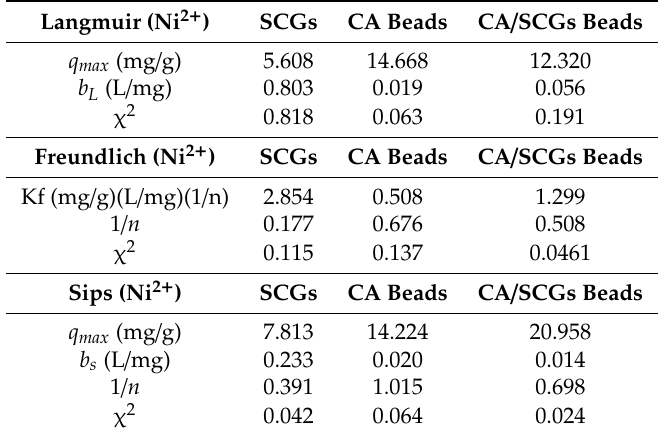
Table 3. Adsorption isotherm constants and chi-square test χ 2 values for each model (Ni 2+ ).